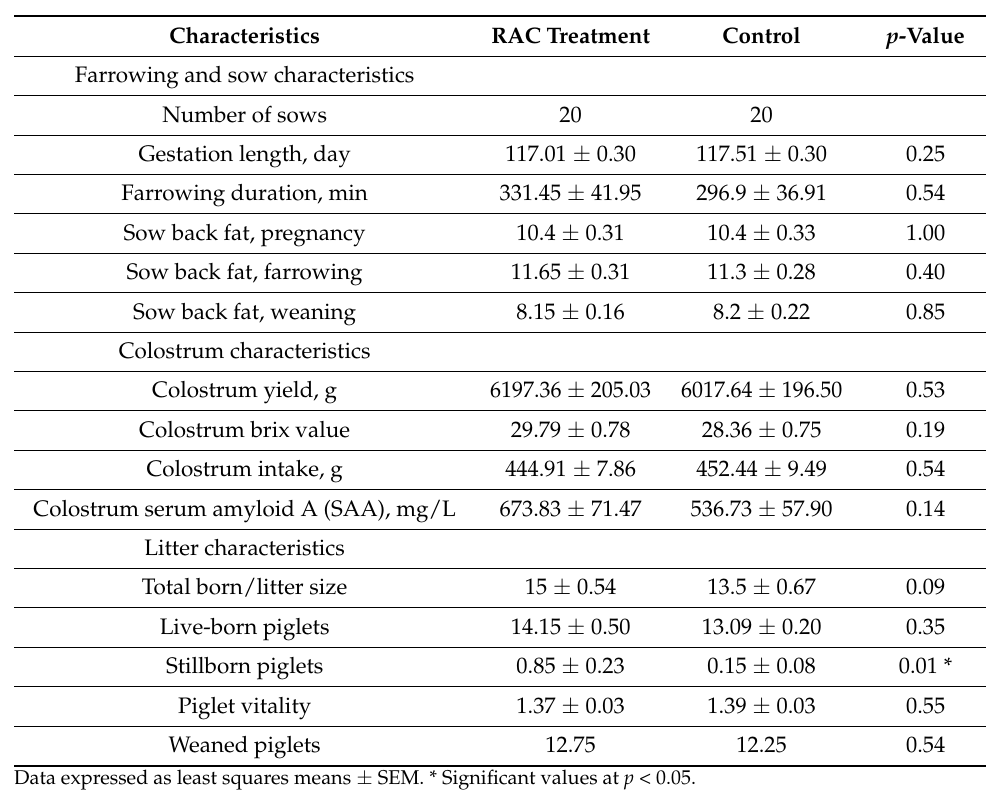
Table 1. Effect of dietary supplementation of sows with resin acid-enriched composition on farrowing and piglet characteristics.